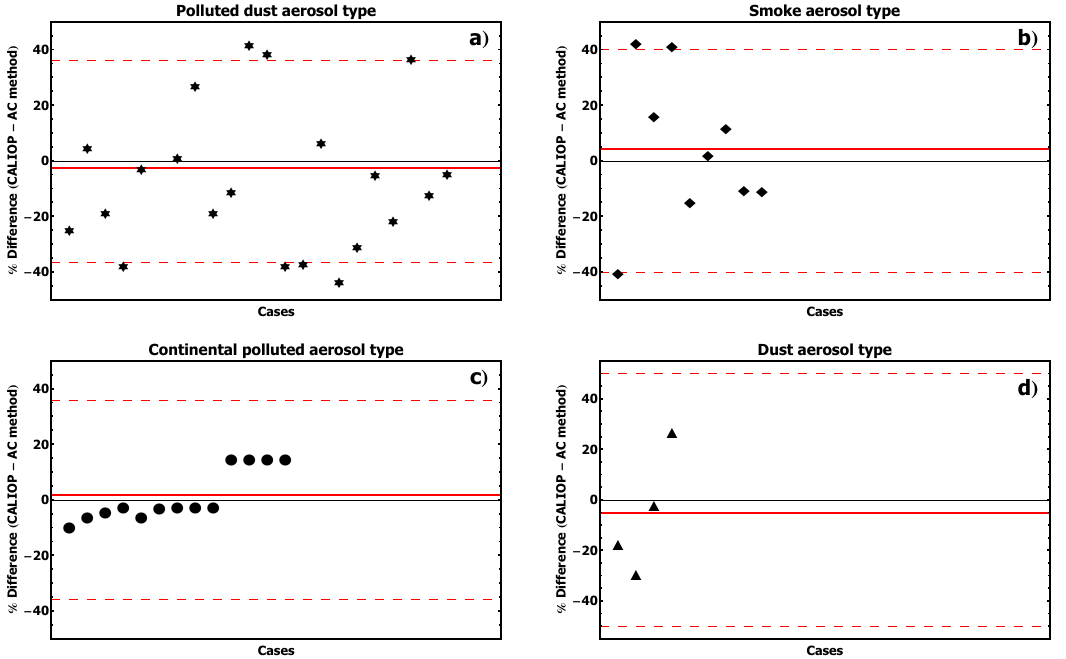
Fig. 7. Lidar ratio mean percentage difference from CALIOP and the AC model separated according to CALIOP aerosol type and using only the best matching profiles approach. The red dashed lines represent one modeled standard deviation, and the red solid line represents the mean percentage difference values (Eq. 8) for each